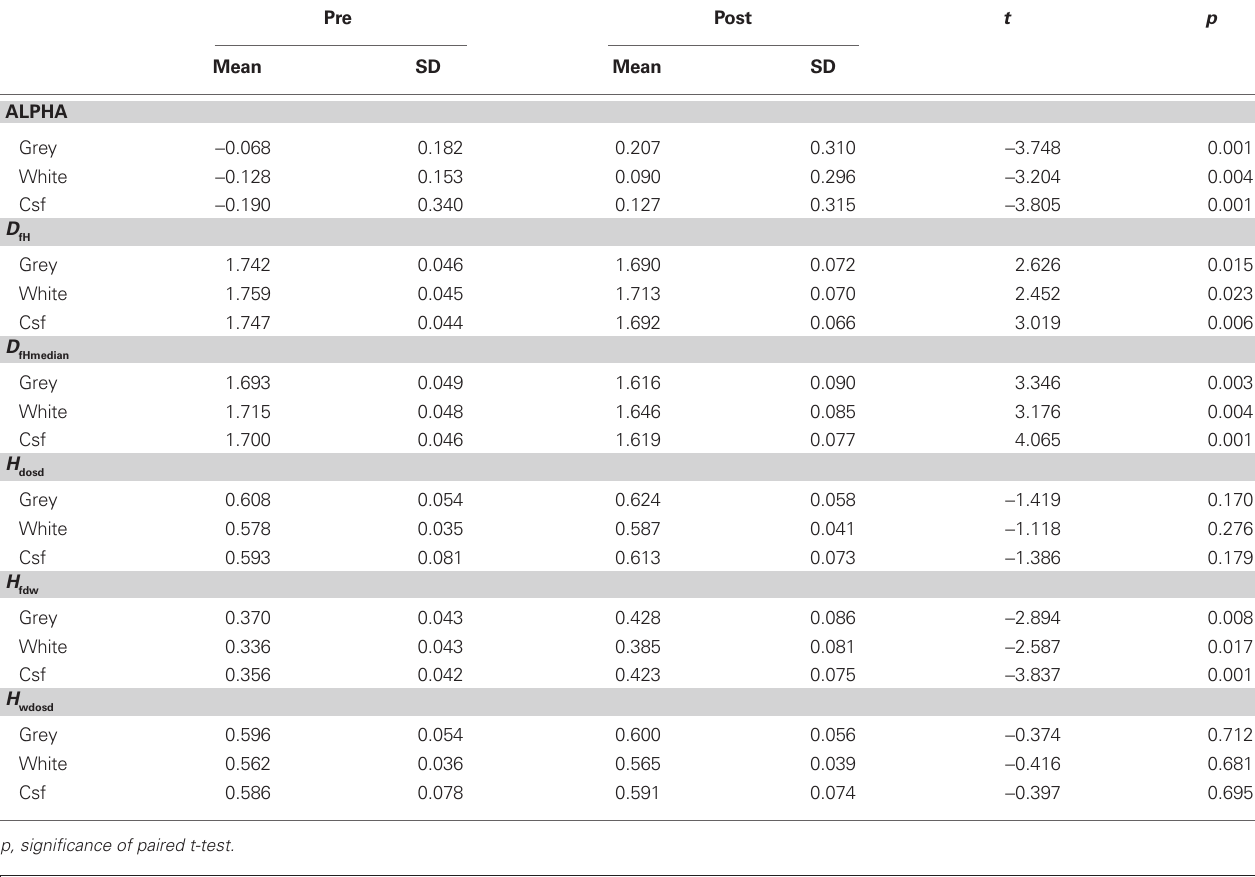
Table 2 | Mean (SD) metrics based on the fGn model of grey matter, white matter, and CSF, before and after